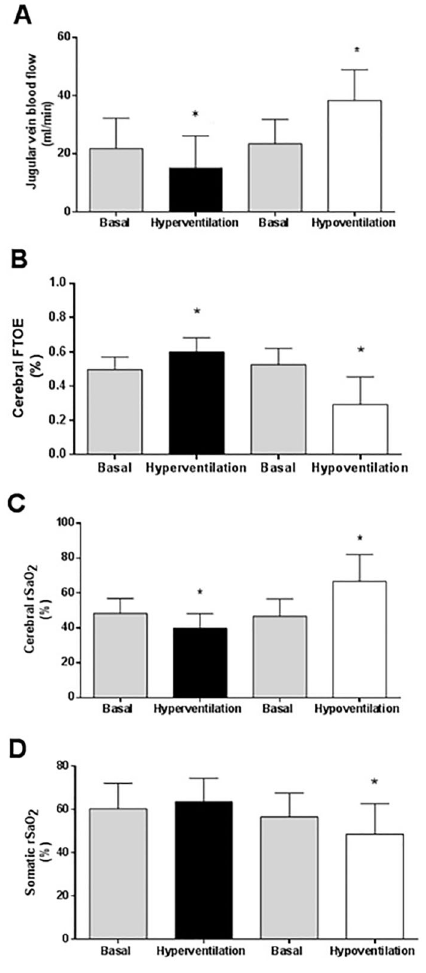
Figure 3. Changes after hyper- and hypoventilation in A , jugular vein blood fl ow; B , fractional cerebral tissue oxygen extraction (FTOE); C , cerebral oxygen saturation (rSaO 2 ); and D , somatic rSaO 2. Data are reported as means ± SD. *P o 0.05 compared to basal ( t